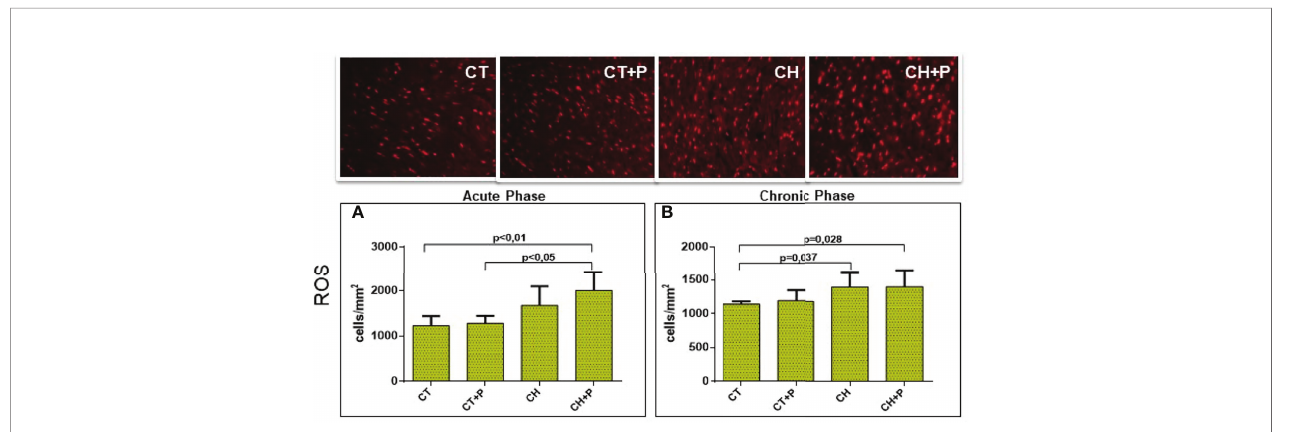
FIGURE 8 | Photomicrograph of the myocardium for detection of reactive oxygen species (ROS) and graph of ROS quanti fi cation. (A) ROS in the acute phase (n=5); (B) ROS in the chronic phase (n=5). CT - control group, CT+P – control group exposed to pollution, CH – chagasic group, CH+P – chagasic group exposed to